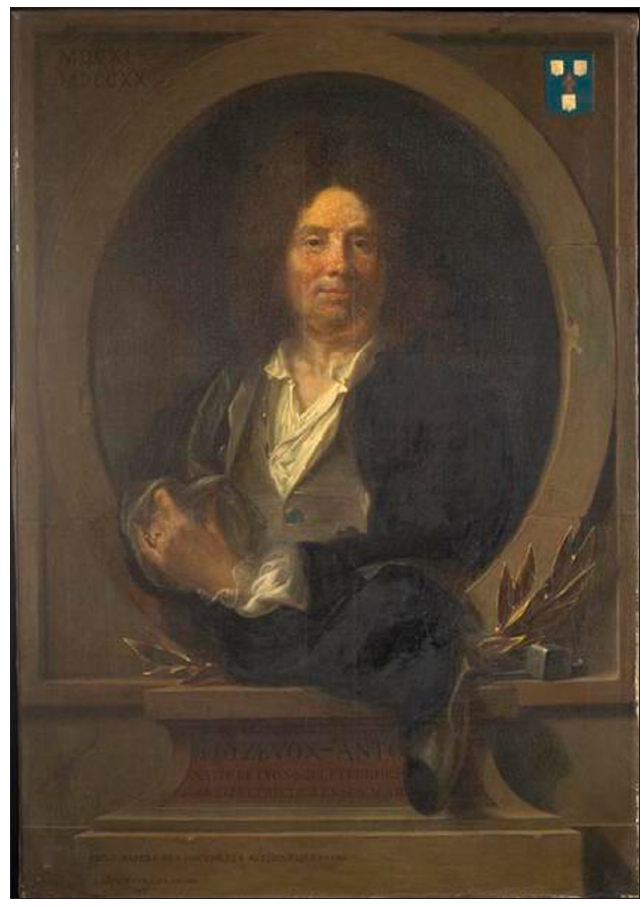
Fig. 6 : Alain-Marie Michel-Villeblanche (after Hyacinthe Rigaud), Portrait of the sculptor Antoine Coysevox, 1882, oil on canvas, 120 × 84.5 cm, Rennes, Musée des Beaux-Arts, INV